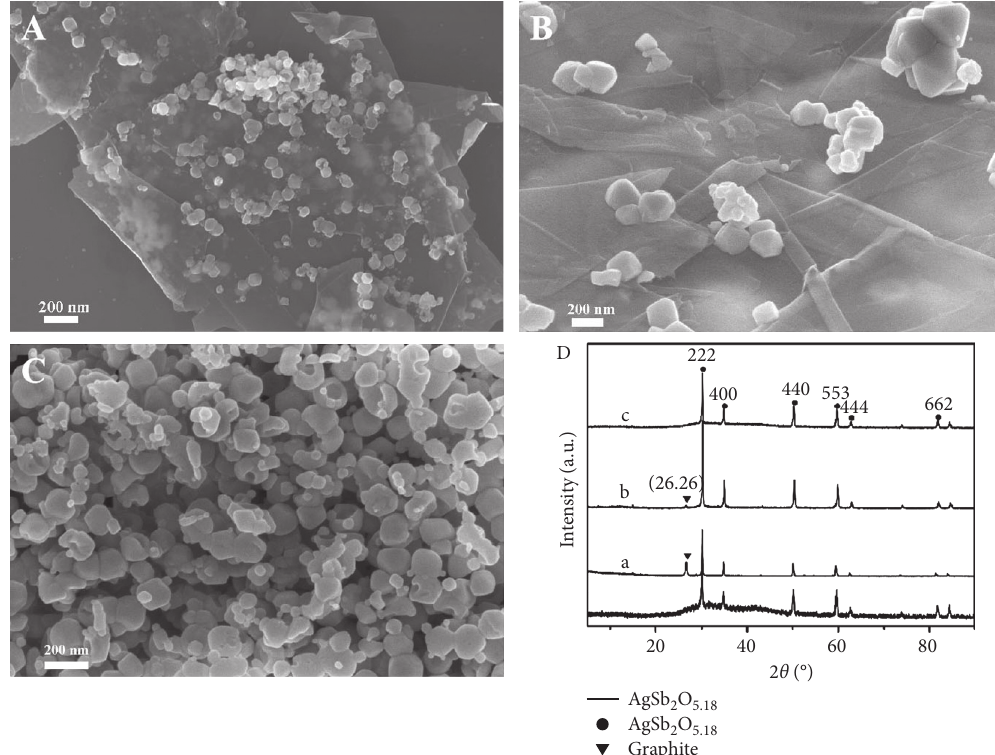
Figure 3: SEM images of (a) G@Ag/ASO-250, (b) G@Ag/ASO-500, and (c) G@Ag/ASO-750; (d) XRD patterns of the different composites: (A) G@Ag/ASO-250; (B) G@Ag/ASO-500; (C)